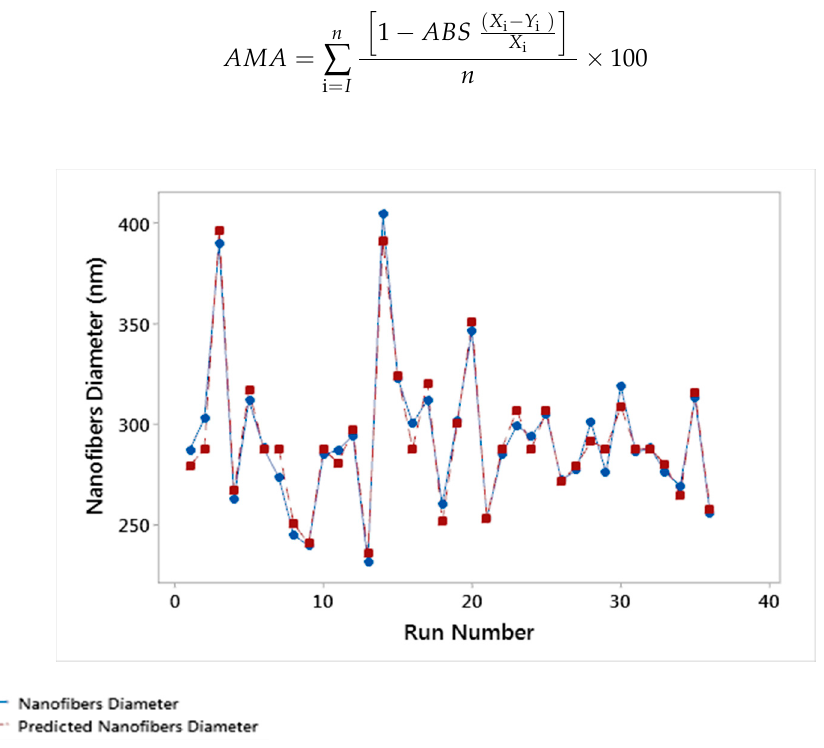
Figure 5. Model predicted nanofibers diameter in relation to the current experimental